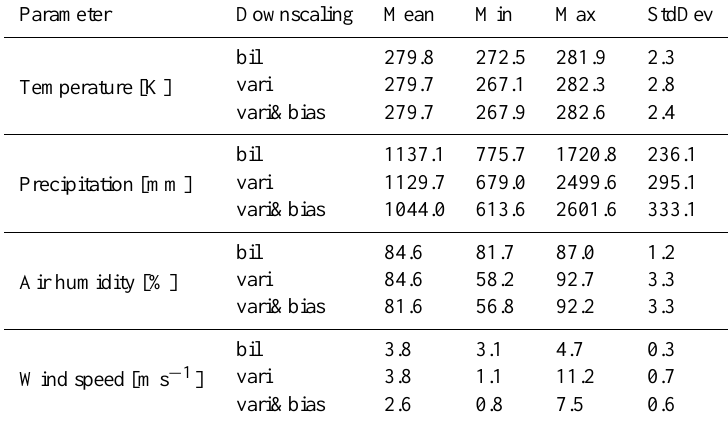
Table 1. Spatial statistics of the downscaled ERA40-driven MM5 simulations (1 × 1km) for the Upper Danube Watershed derived from mean values of the period 1971–2000. The abbreviations represent the mean value (Mean), the minimum value (Min), the maximum value (Max) and the standard deviation (StdDev). Parameter Downscaling Mean Min StdDev Temperature [K]